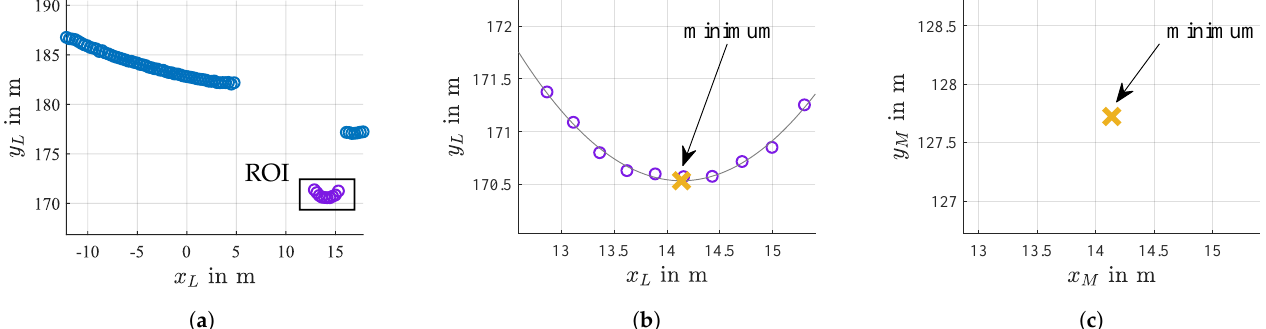
Figure 3. Procedure for determining the minimum in the horizontal scanner alignment by defining the region of interest (ROI), least-squares fitting, and transformation of the minimum to coordinate system ( x M , y M ) . ( a ) Points on the tower marked as the region of interest (ROI) in the coordinate system ( x L , y L ). ( b ) Parabola fitted through points in the ROI and minimum ( x L ,min , y L ,min ) calculated in the coordinate system ( x L , y L ). ( c ) The minimum ( x M ,min , y M ,min ) is then analyzed in the coordinate system ( x M , y M )